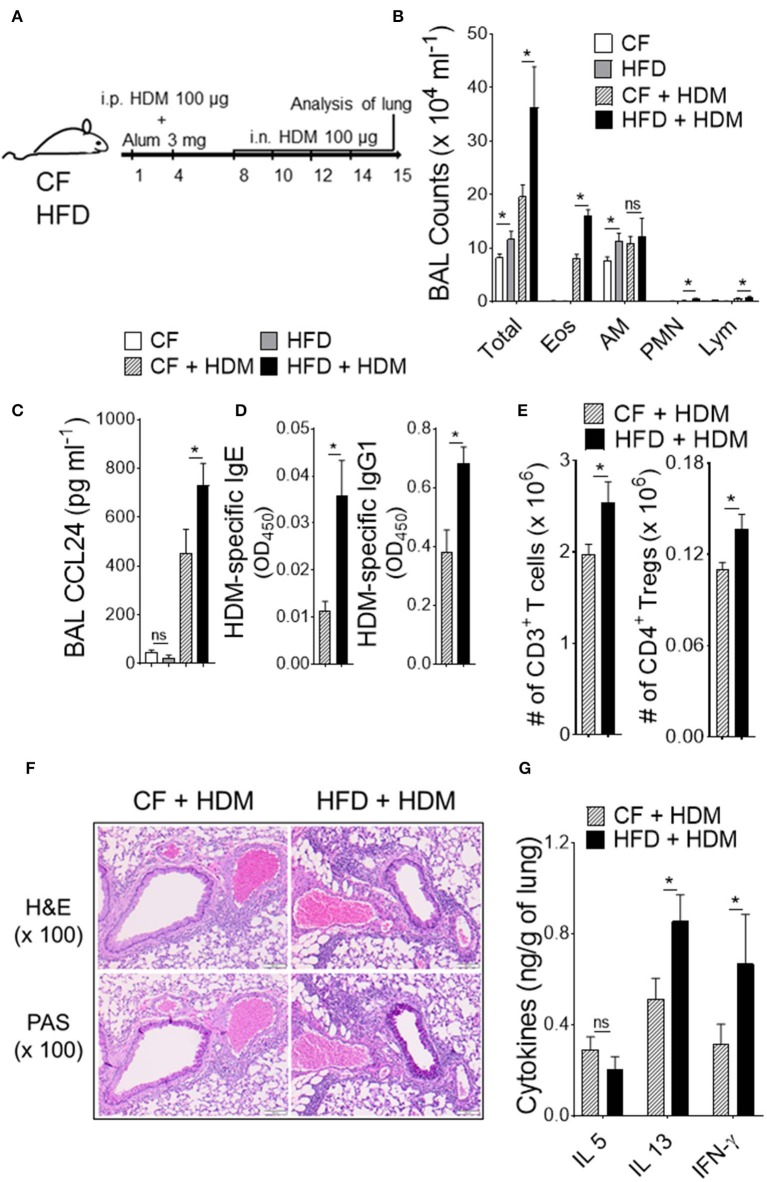
Obesity increases the severity of airway inflammation. (A) Timeline for sensitization and challenge. CF or HFD mice were immunized with HDM, as indicated. i.n., intranasal; i.p., intraperitoneal. (B) Differential cell counts and (C) CCL24 in BAL. (D) Plasma levels of HDM-specific IgE and IgG1 assessed by ELISA. (E) Enumeration of total T cells and Tregs from lung draining mediastinal lymph nodes. (F) Hematoxylin and eosin (H & E) and periodic acid-schiff (PAS)-stained lung sections (Scale bars 100 μm for 100x images). (G) Lung cytokine levels were measured by means of ELISA. Data are representative of two independent sets of experiment and expressed as mean ± s.e.m. n = 8–10/group. One-way ANOVA with Sidak's multiple comparison test *P < 0.05. Eos, Eosinophils; AM, Alveolar macrophage; PMN, Neutrophils; Lym, Lymphocytes; Tregs, T regulatory cells.